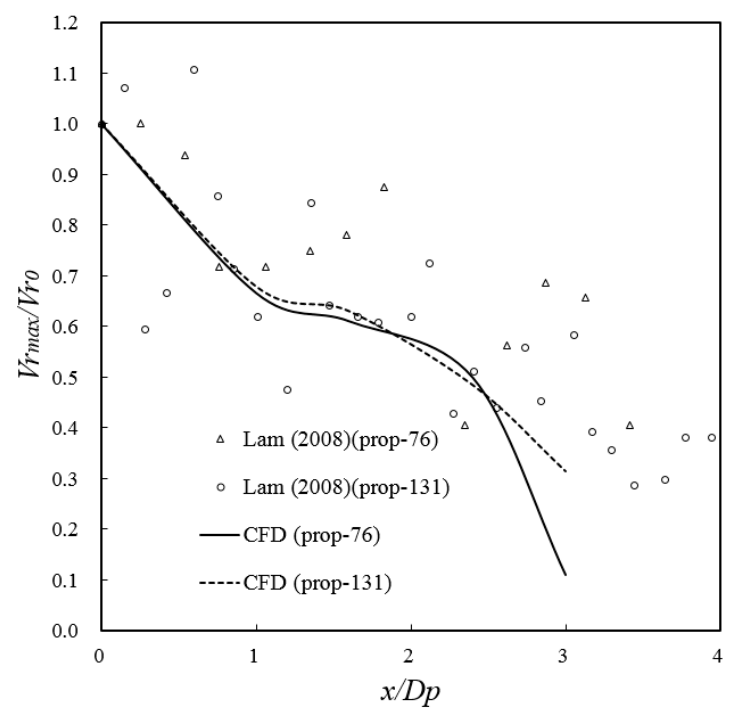
Figure 14. Radial velocity decay.